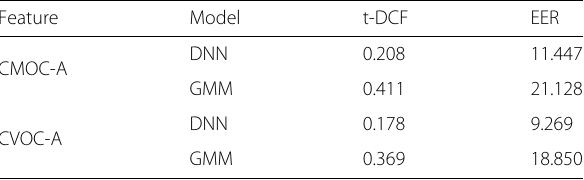
Table 13 Comparison with GMM on ASVspoof 2019 physical access evaluation set in terms of t-DCF and EER (%) Feature Model